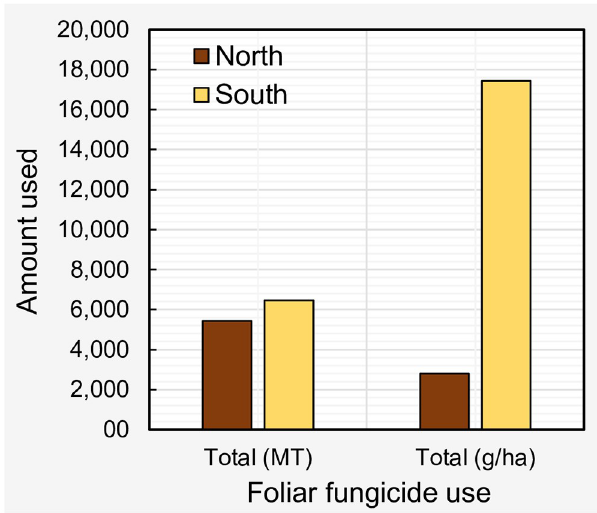
Fig 2. Total foliar fungicide use (from 2005 to 2015) by region. Northern states = IL, IN, IA, KS, MI, MN, NE, ND, OH, PA, SD, and WI; Southern states = AL, AR, DE, FL, GA, KY, LA, MD, MO, MS, NC, OK, SC, TN, TX, and VA. Fungicides included: quinone outside inhibitors = azoxystrobin, fluoxastrobin, picoxystrobin, pyraclostrobin, trifloxystrobin; demethylation inhibitors = cyproconazole, difenoconazole, flutriafol, propiconazole, prothioconazole, tebuconazole, tetraconazole; methyl benzimidazole carbamates = thiophanate-methyl; multi-site mode of action = chlorothalonil; and succinate dehydrogenase inhibitors = fluxapyroxad.